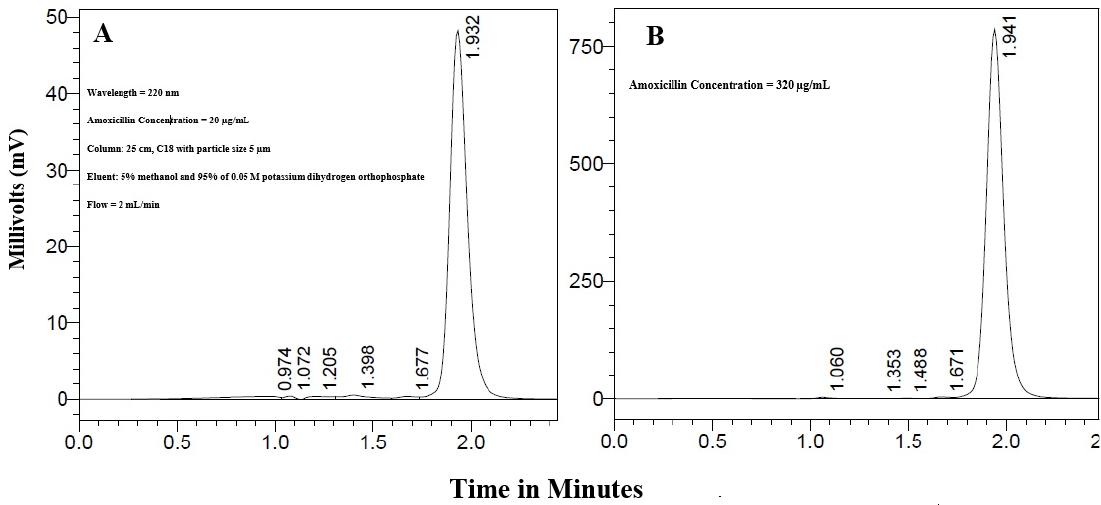
Figure 1. ( A ) Absorption peaks obtained for amoxicillin concentrations 20 µg/mL and ( B ) 320 µg/mL using HPLC.